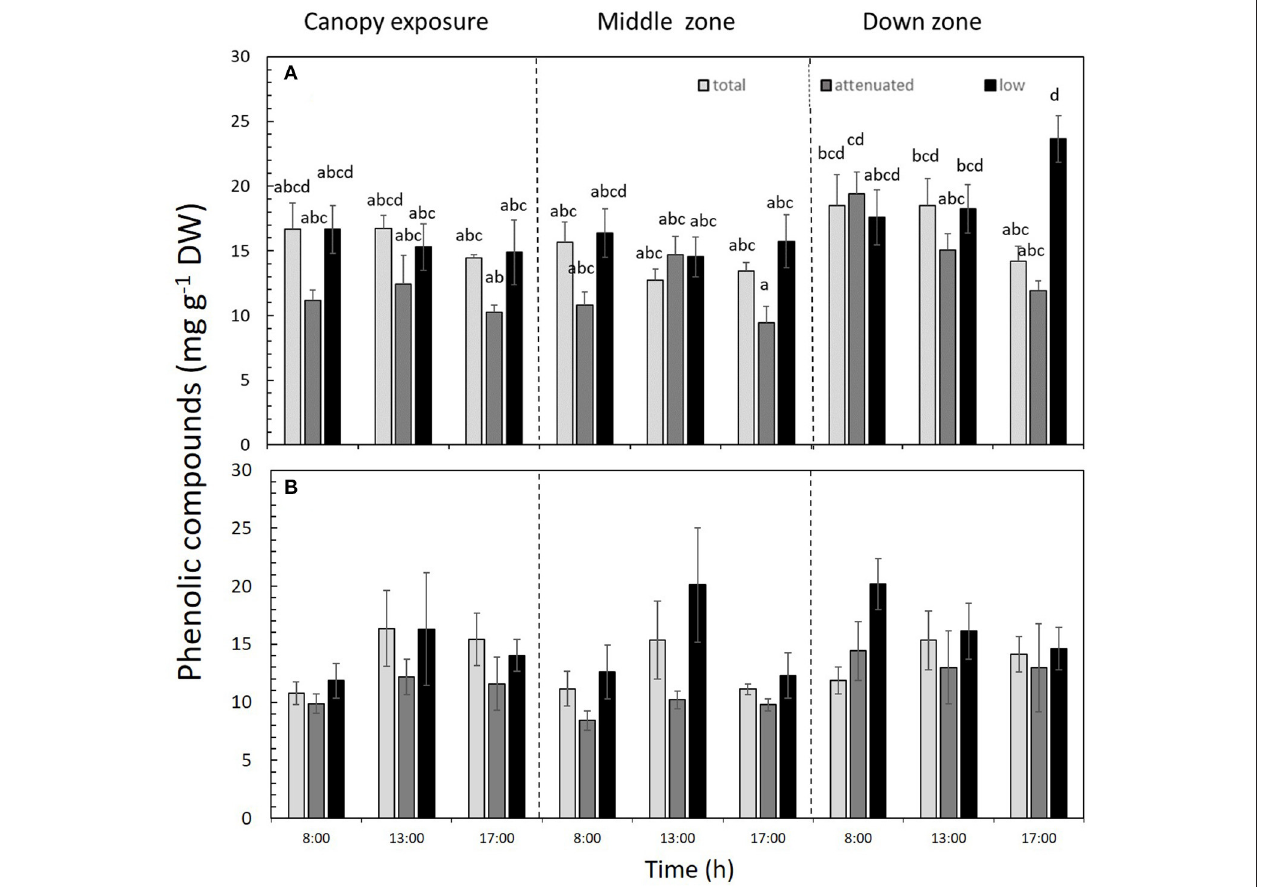
FIGURE 7 | Phenolic compounds (PC, mg g − 1 DW) in Macrocystis pyrifera fronds during the first daily cycle experiment (A) and the second daily cycle experiment (B) according to the different solar irradiance treatments (total, attenuated, and low radiation) and time points (8:00, 13:00, and 17:00) and zones of the macroalga (canopy, middle, and down). Shown is the mean ± SE ( n = 3). Lower-case letters denote significant differences after the SNK